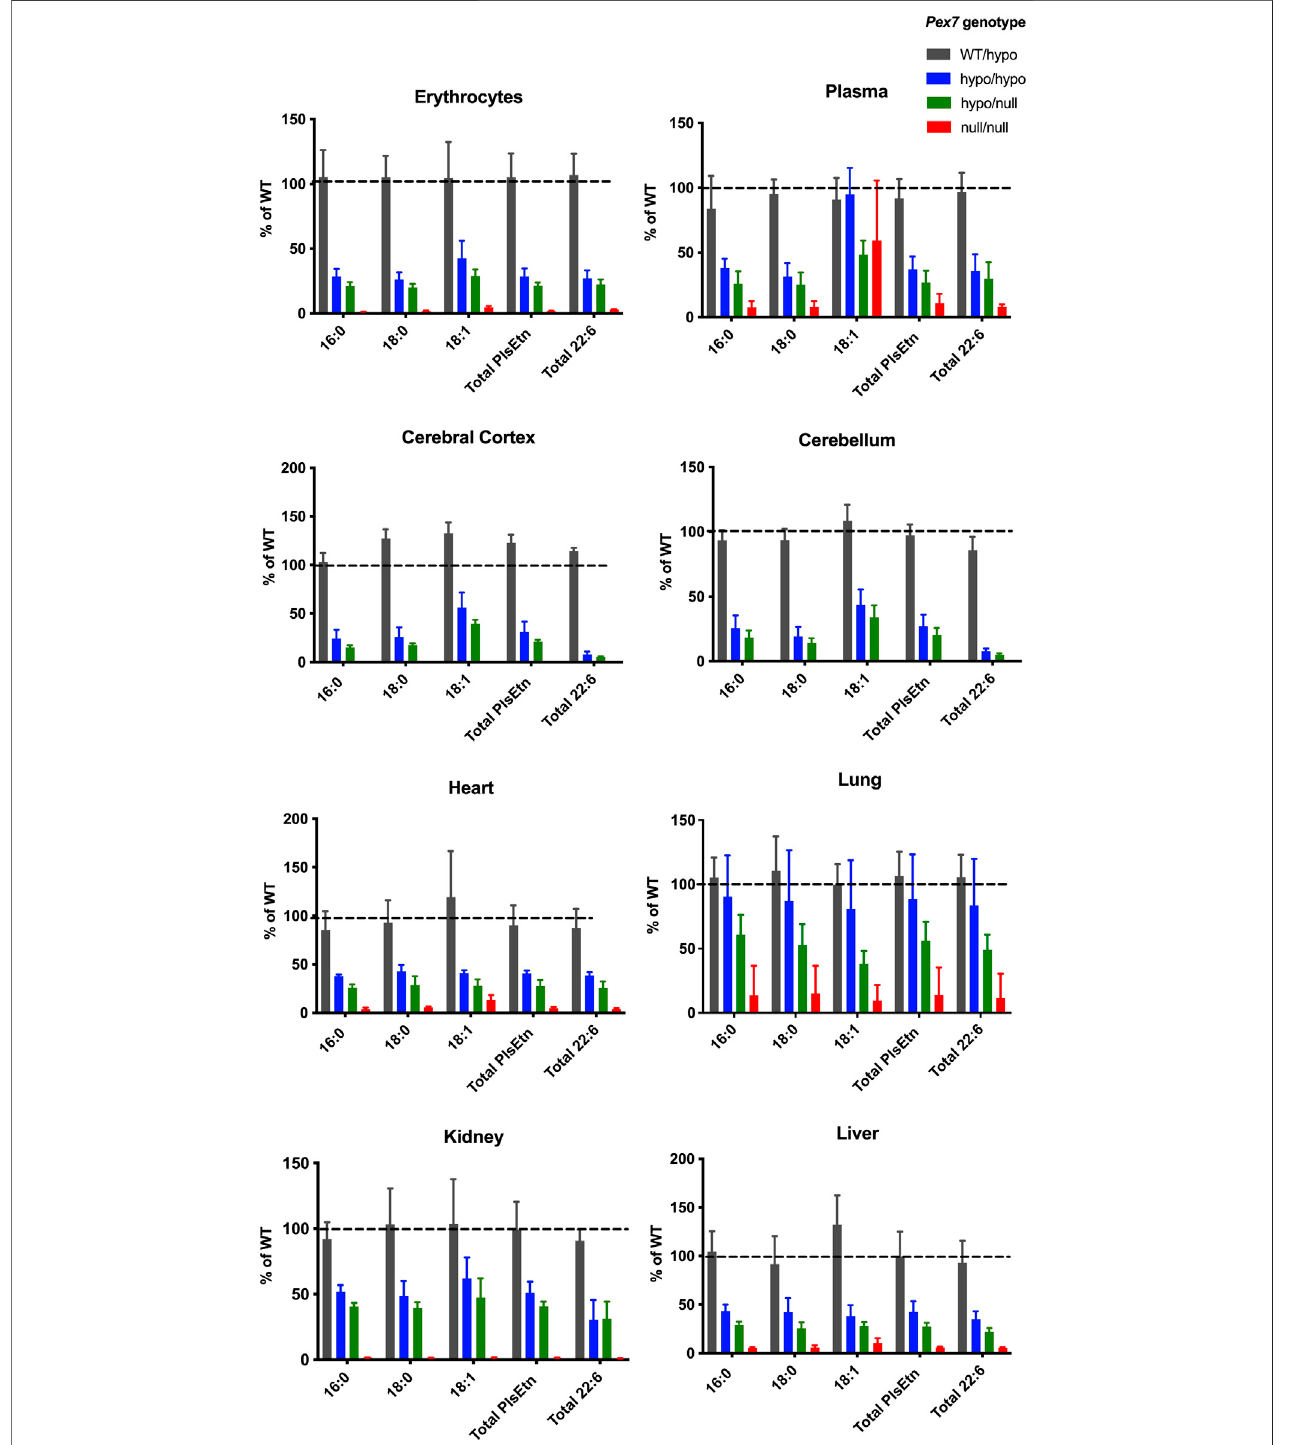
FIGURE 4 | Pex7 genotype correlates with PlsEtn levels. Pls levels [reported as the percentage of wild type (% of WT)] are signi fi cantly decreased in all tissues studied in accordance to the severity of the genotype of Pex7 de fi cient mice ( p < 0.0001 , n = 4 – 6 per genotype). The C16:0, C18:0, and C18:1 represent the sum of individualmeasurementsofthePlsEtnspecieswithC16:0,C18:0,orC18:1fattyalcoholatthe sn- 1position.TotalPlsEtnreferstothesumofthesespeciesandthetotal C22:6 represents the sum of C16:0, C18:0, and C18:1 Pls containing C22:6 fatty acid side chains at the sn- 2 position.